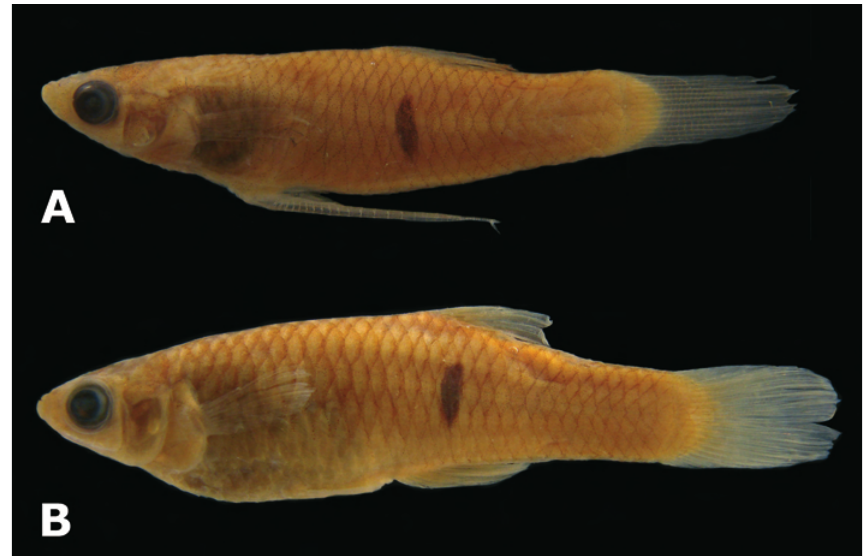
like (Fig. 17). Color in alcohol . Eye greyish iridescent black with greenish brown pupil. Ground color cream, darker in upper half. Border of scales and subjacent skin replete with brown chromato-